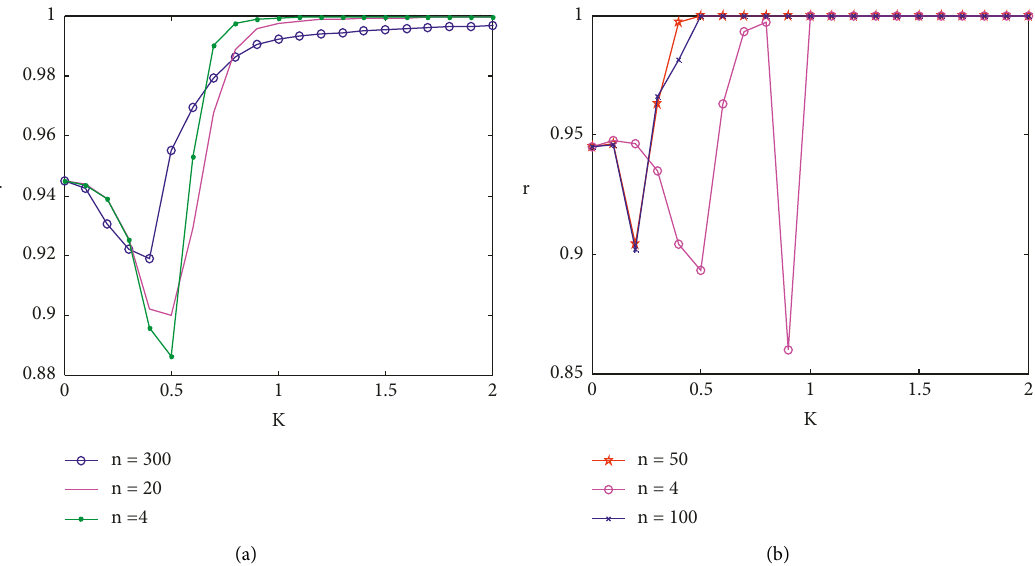
Figure 8: The influence of nodes number on dynamics behavior of network with different structures: (a) ring-like topology structure and (b) network with WS